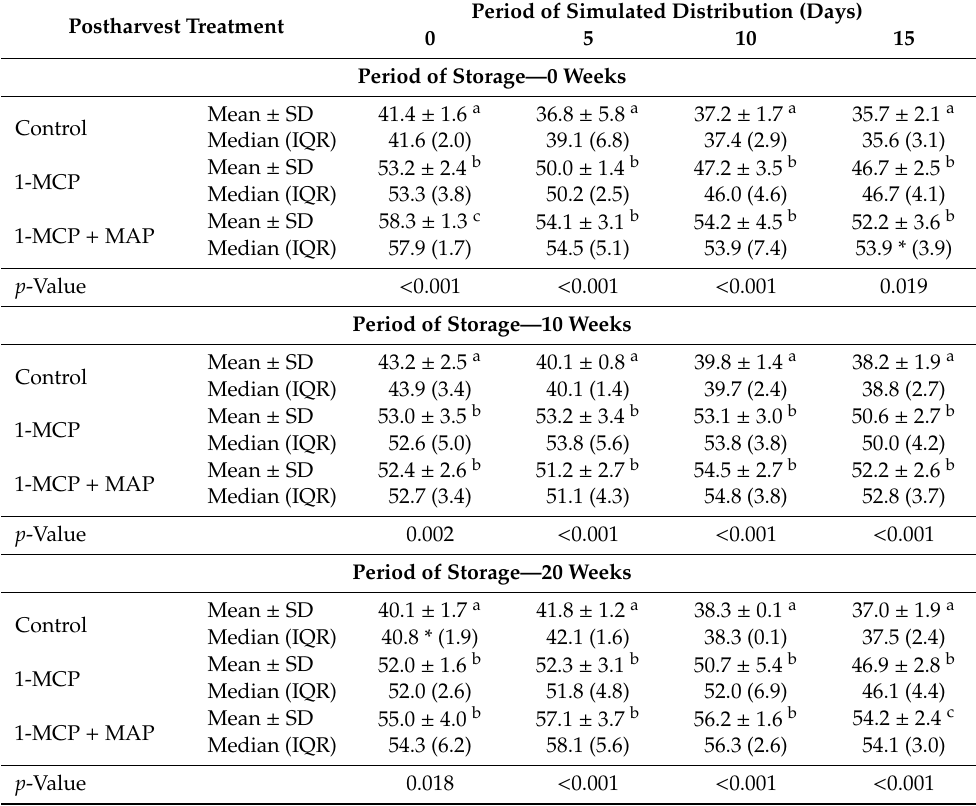
Table 2. The firmness [N] values of ‘Idared’ apples after Ultra Low Oxygen (ULO) storage, simulated long-distance transport, and simulated distribution, stratified by postharvest treatment, period of storage and period of